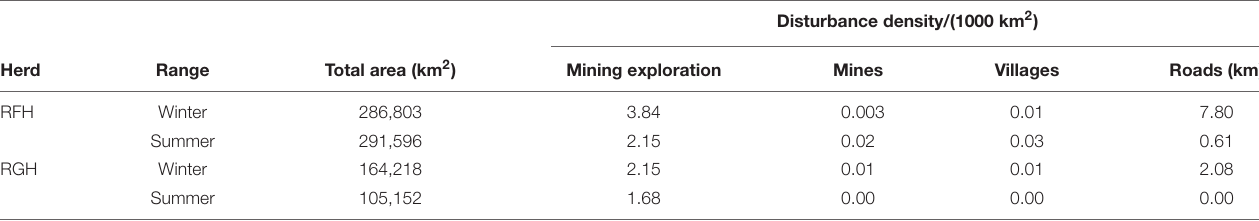
TABLE 1 | Total area (km 2 ) of caribou seasonal ranges and density of human disturbances (per 1000 km 2 ) in the ranges of the Rivière-aux-Feuilles (RFH) and Rivière-George (RGH) herds in northern Québec and Labrador, Canada, 2009 − 2016.